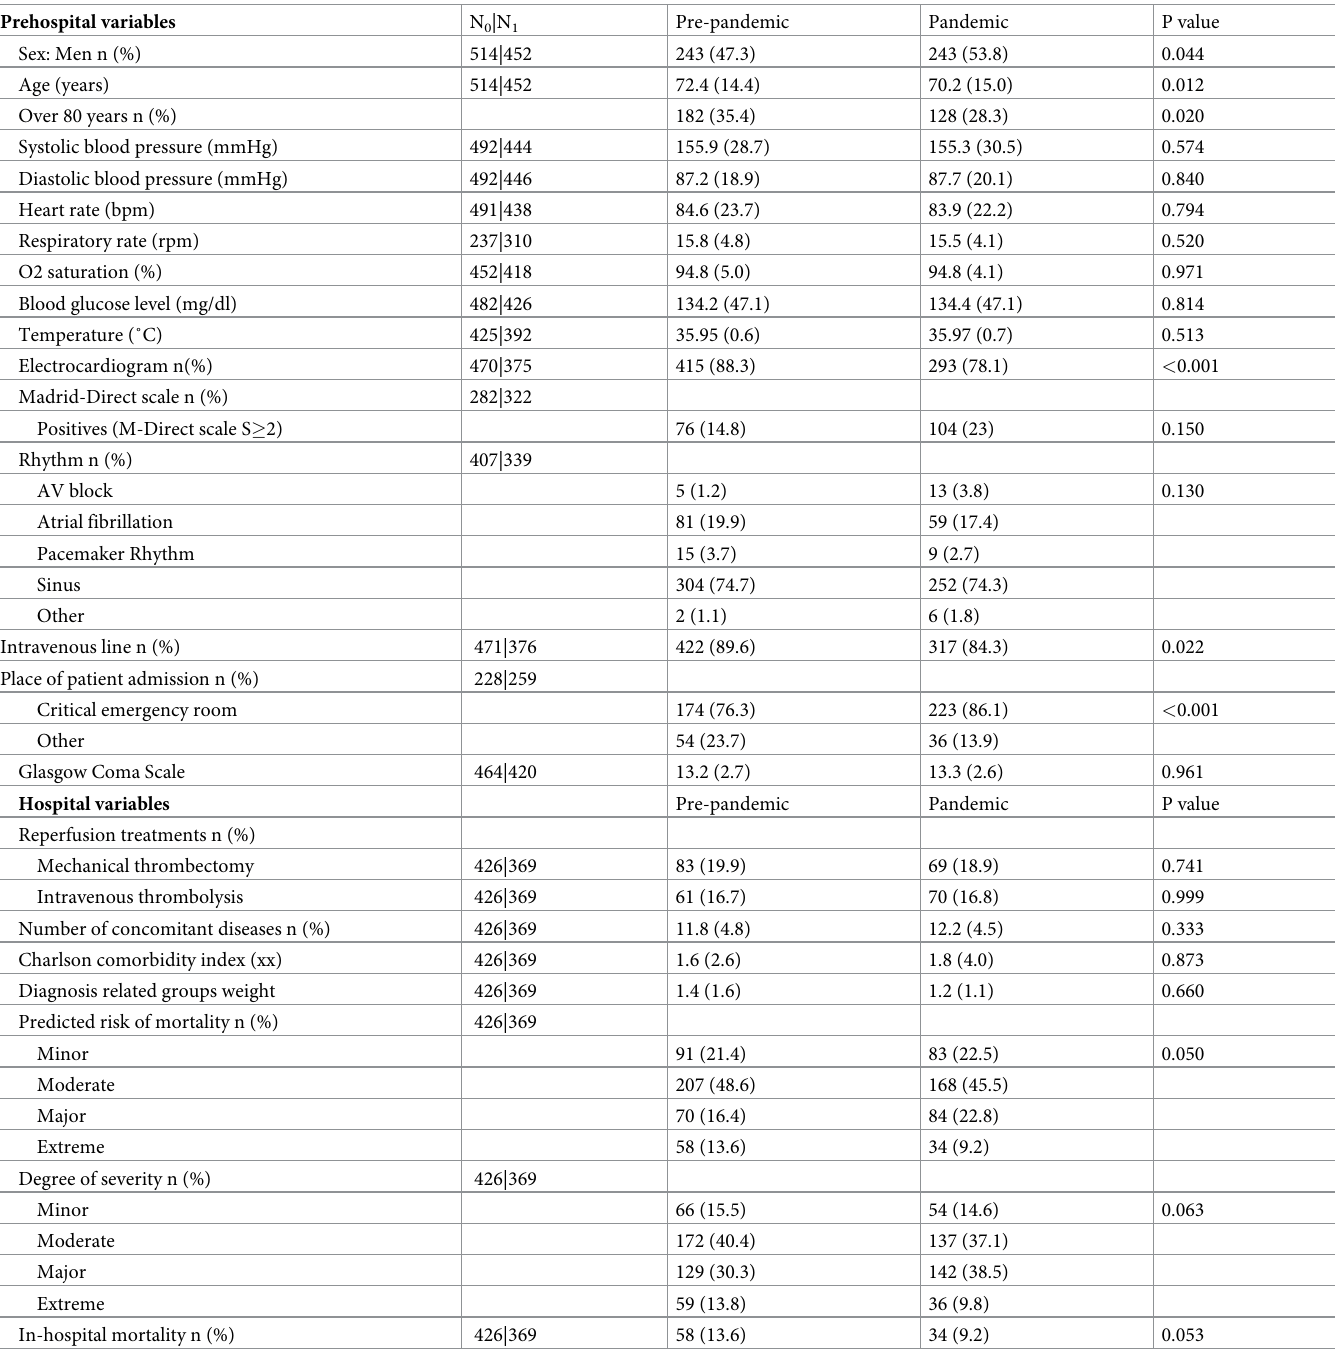
Table 1. Baseline